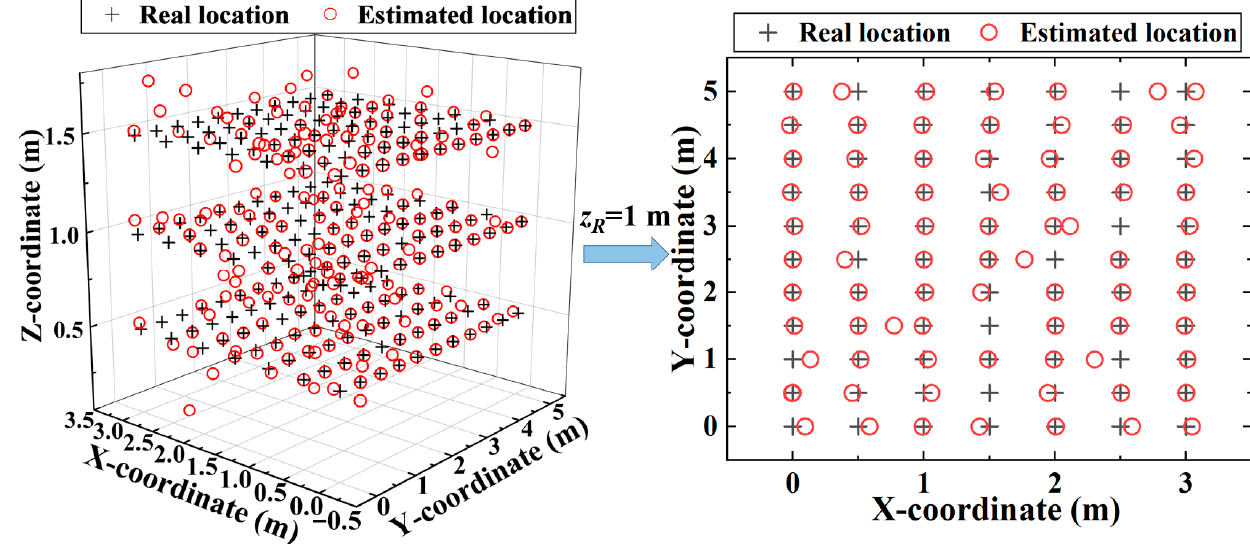
Figure 5. An example of 3D positioning results. ( θ = 0°).